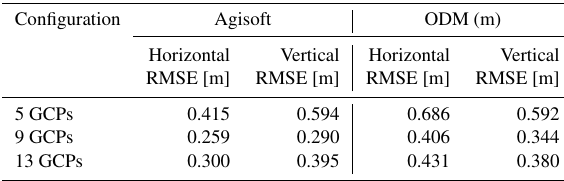
Table 1. RMSE of different GCP